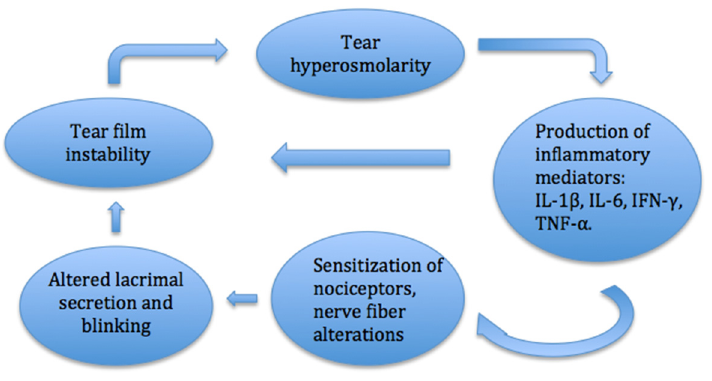
Figure 2. Pathophysiology of dry eye disease.